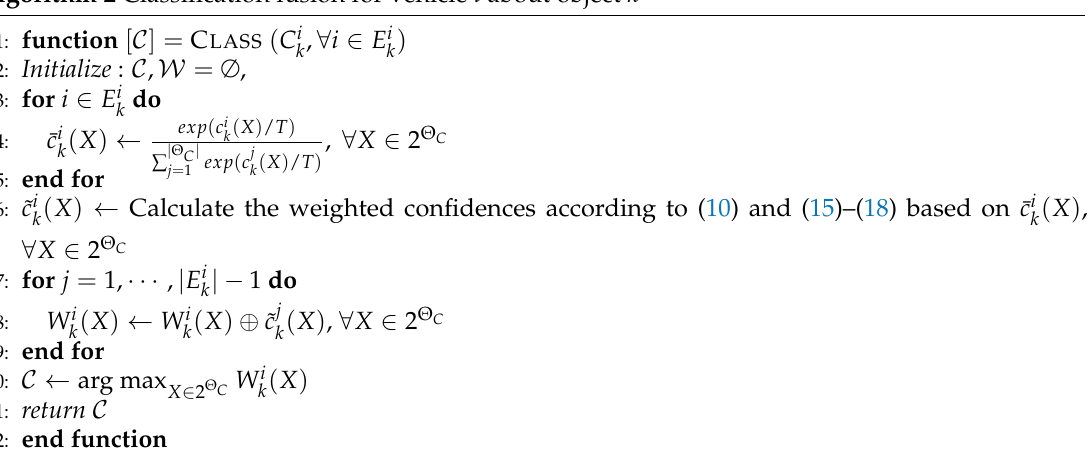
Algorithm 2 Classification fusion for vehicle i about object